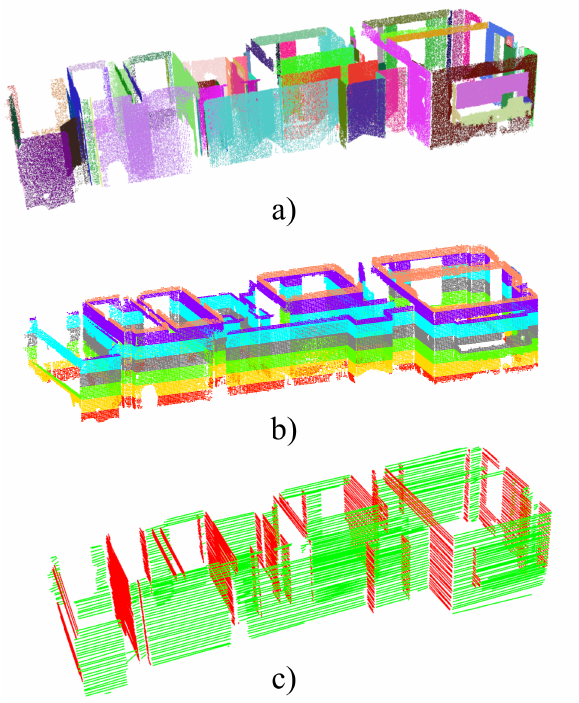
Figure 7. Point cloud partition and linear fitting: ( a ) The planar primitives from vertical structures, ( b ) the 2D projections of consecutive blocks (each color represents ten layers), ( c ) the result of the linear fitting (Red lines: Vertical primitives; Green lines: Horizontal primitives).